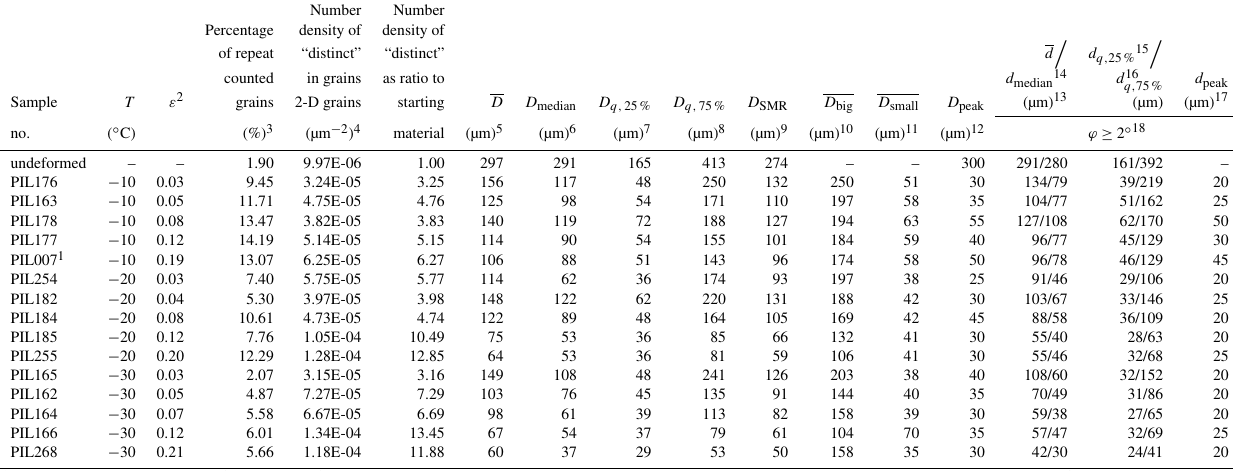
Table 3. Summary of subgrain and grain sizes.